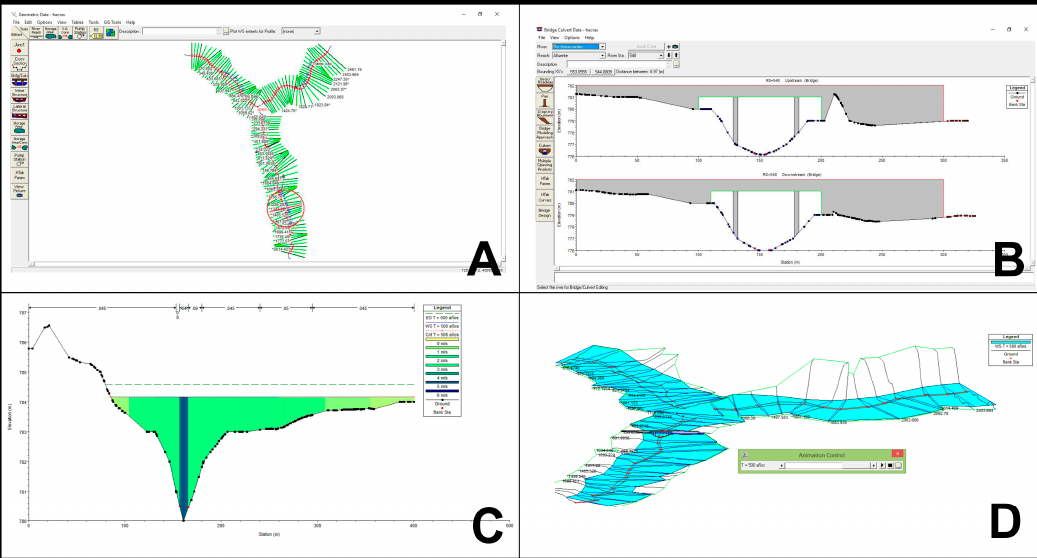
Figure 7. Processes in HEC-RAS: ( A ) Riverbed geometry and view of the HEC-RAS interface program; ( B ) definition of the geometric structure of the bridge upstream and downstream; ( C ) rate profiles for steady flow conditions; and ( D ) an example of the results of the three-dimensional models of the analysis of flooding for each time return in HEC-RAS.